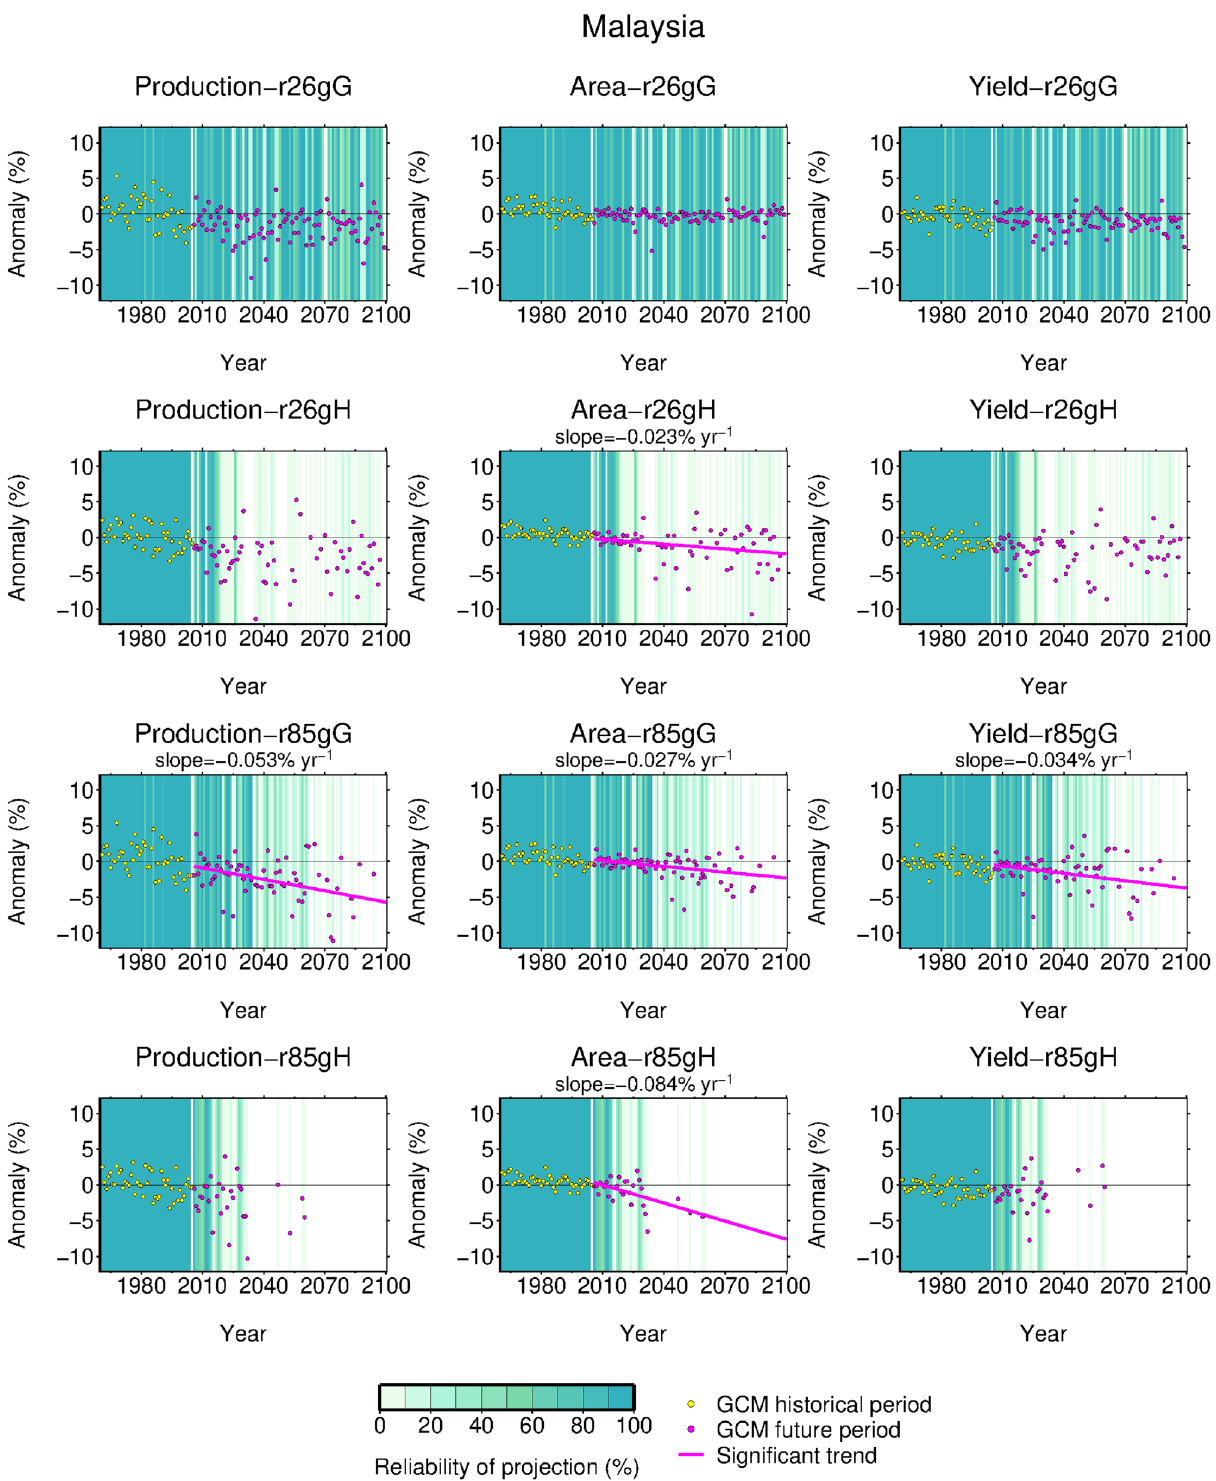
Figure 4. Projected changes in production, area, and yield for Malaysia. The heat map overlayed on each panel indicates the reliability of the projection. Lighter green and white columns indicate that many climatic predictors used to derive the projection fall outside the observed ranges; therefore, these projections are less reliable than projections in the darker green column. Less reliable projection samples are eliminated when fitting a trend line and testing the significance of the slope. Trend lines and the corresponding slope values are displayed only when a significant slope is